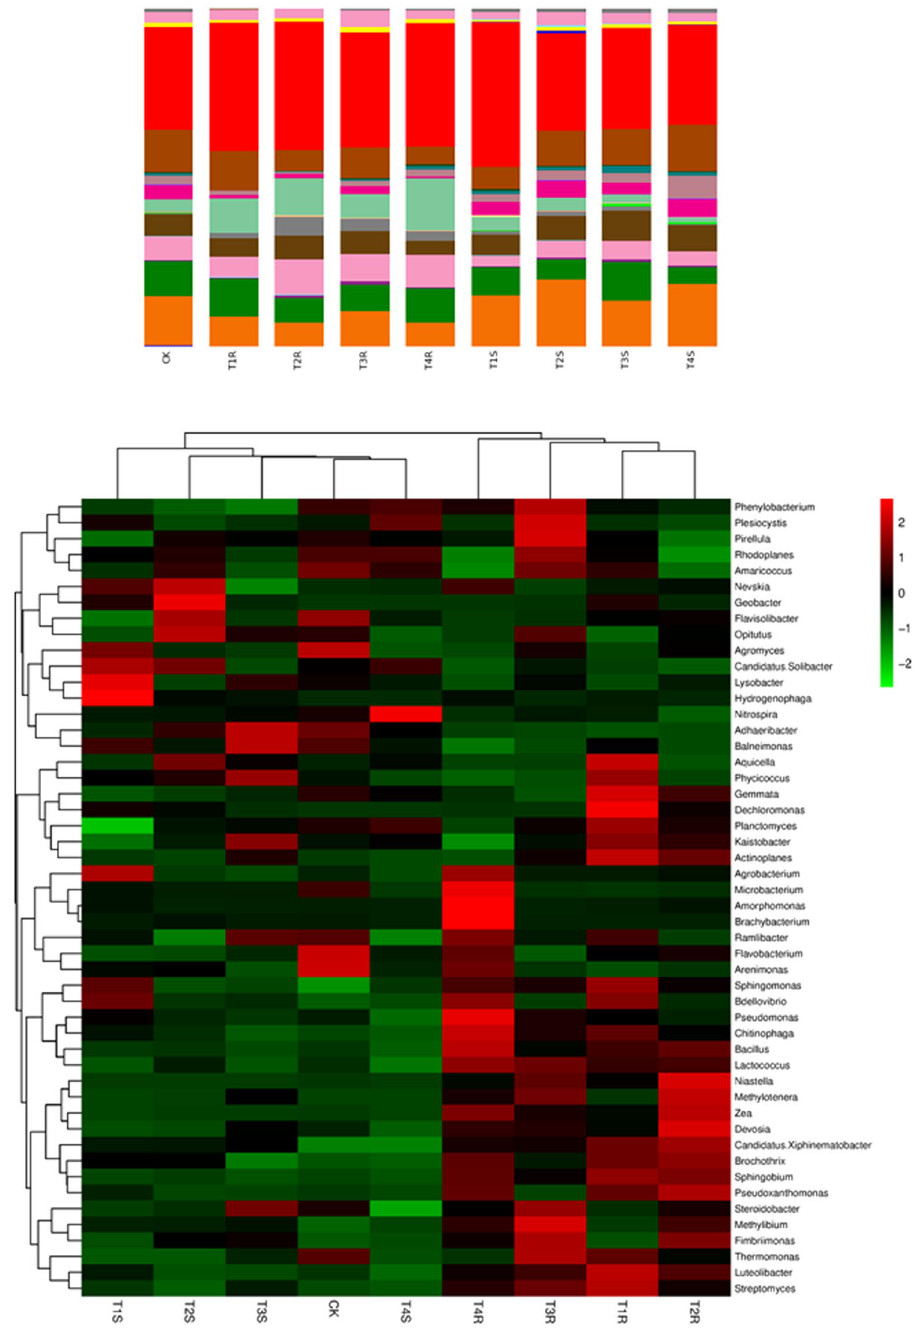
Figure 4. Analysis of bacterial OTUs ( a ) Taxonomical distribution of bacterial OTUs, ( b ) Heatmap analysis of OTUs of bacterial species based on the Bray- Curtis similarity of 454